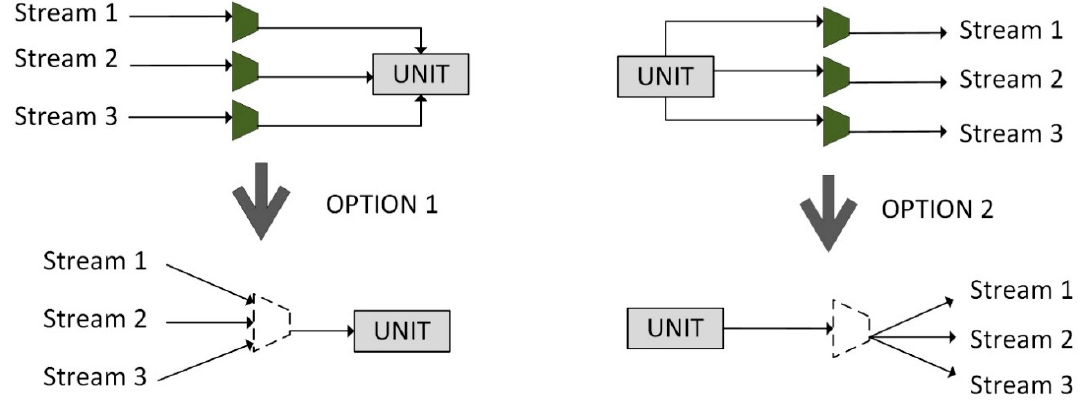
Figure 2. Virtual Compressor Approach–Possibilities of mixing streams in the compressors.